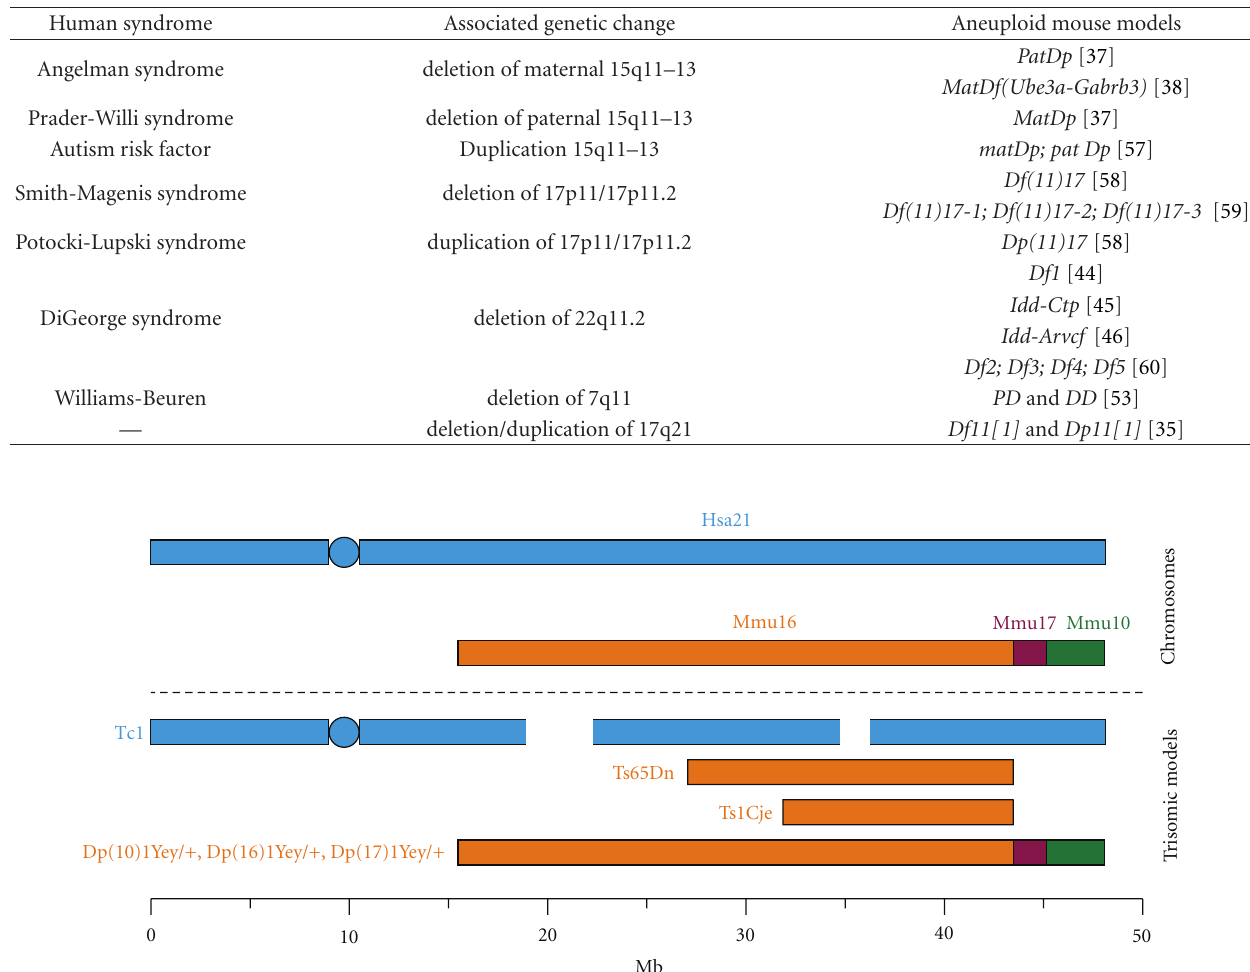
Table 1: Examples of mouse models of segmental aneuploidies.